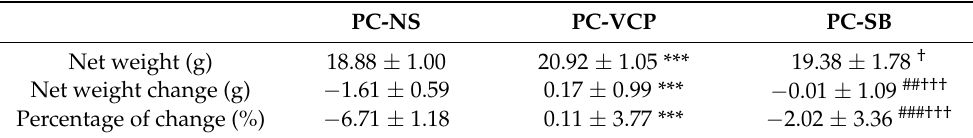
Table 3. Weight change in mice with and without the p38 MAPK inhibitor